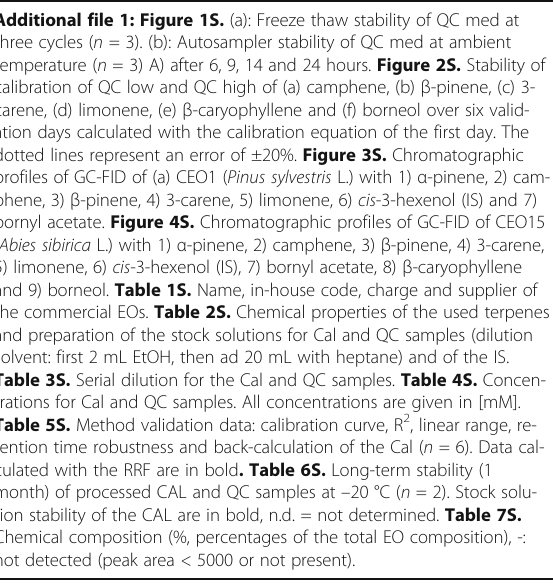
Table 3S. Serial dilution for the Cal and QC samples. Table 4S. Concen- trations for Cal and QC samples. All concentrations are given in [mM]. Table 5S. Method validation data: calibration curve, R 2 , linear range, re- tention time robustness and back-calculation of the Cal ( n = 6). Data cal- culated with the RRF are in bold . Table 6S. Long-term stability (1 month) of processed CAL and QC samples at – 20 °C ( n = 2). Stock solu- tion stability of the CAL are in bold, n.d. = not determined. Table 7S. Chemical composition (%, percentages of the total EO composition), -: not detected (peak area < 5000 or not